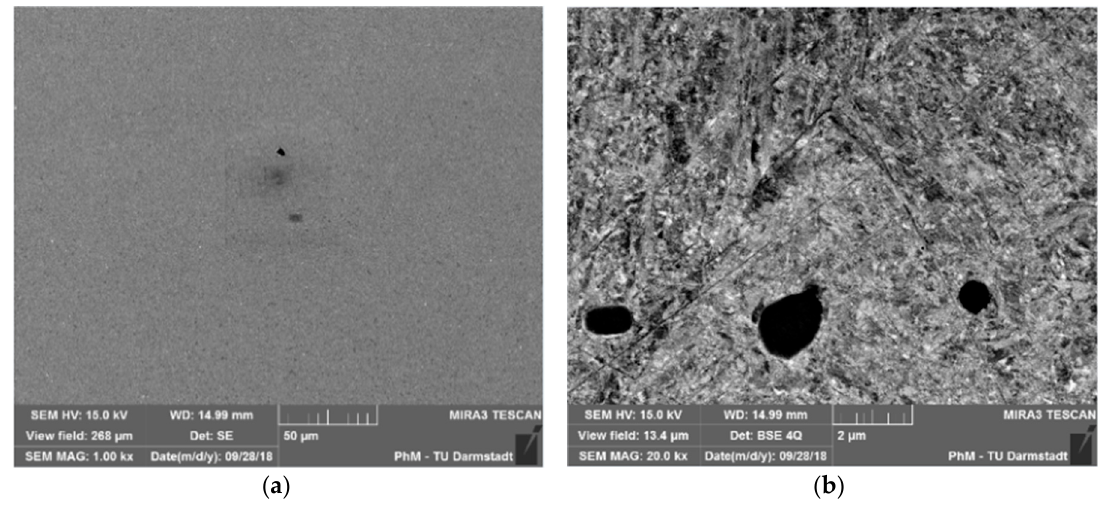
Figure 5. SEM ( a ) and BSE ( b ) image of the hand polished Stavax surface.